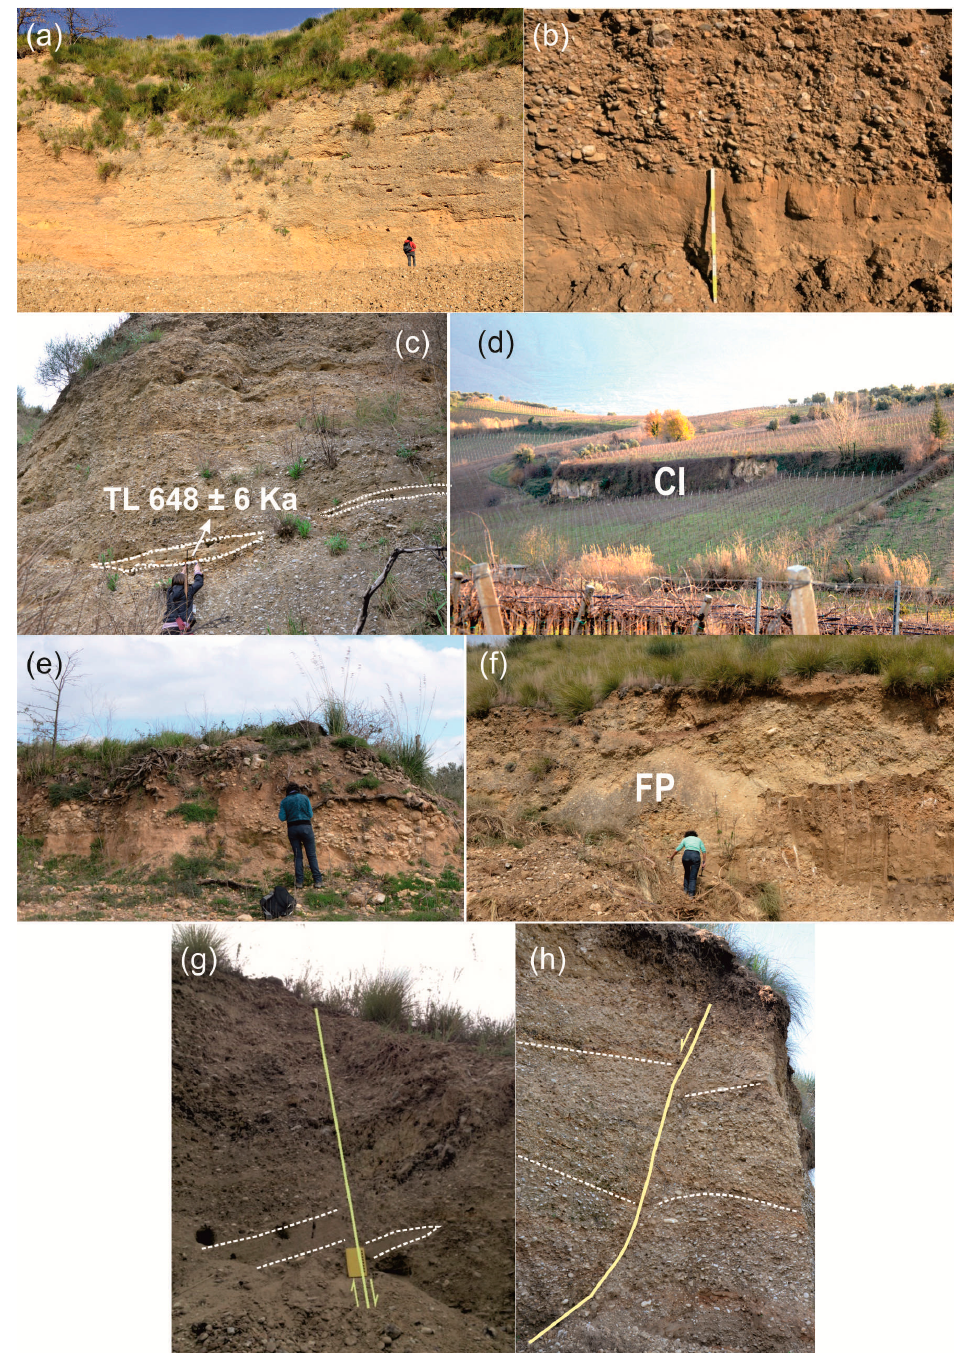
Figure 5. ( a ) Typical outcrop of alluvial unit 1a and ( b ) detail of a sandy-silty layer in the lower part. The length of the scale is 60 cm; ( c ) the 648 ± 6 ka 40 Ar/ 39 Ar dated Tephra layer (TL) interbedded in the alluvial unit 1a at Masseria Acquafredda.; ( d ) the Campanian Ignimbrite (CI) pyroclastic flow deposits cropping out in the V.ne Ariola stream valley; ( e ) massive coarse and medium, poorly rounded polygenic gravels in sandy–silty matrix, cropping out at the top of the oldest HFT remnants; ( f ) fault plane (FP) in the alluvial unit 1a; ( g ) decimetric offset in a sandy layer of alluvial unit 1a highlighting a NE–SW oriented fault; ( h ) dragged pebbles that highlight a NW–SE oriented fault.